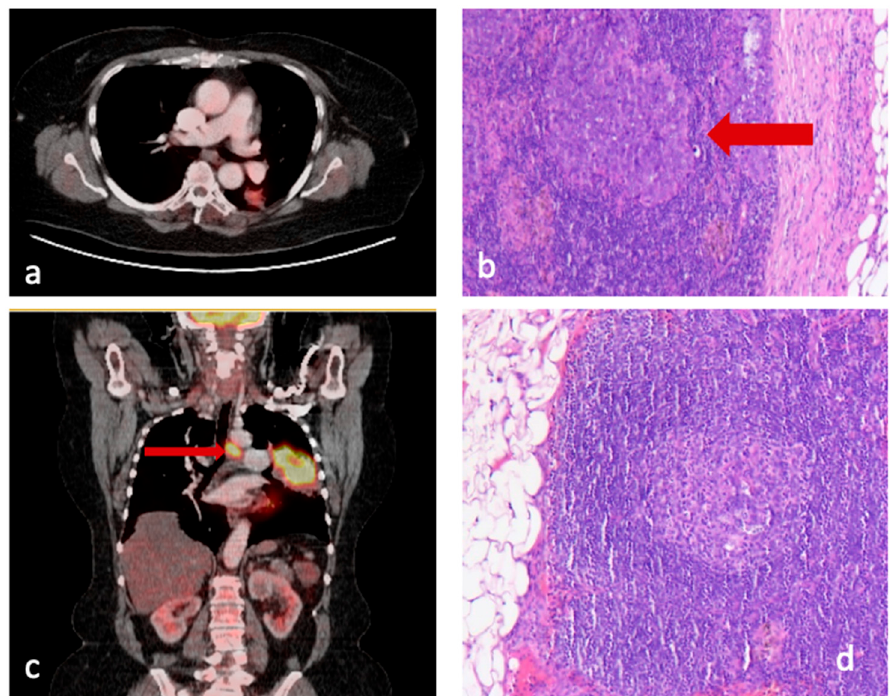
Figure 1. ( a ) PET/CT scan of patient in group 1.2, where there is no suspected LNM; ( b ) Pathological specimen of same patient with HE stain showing metastasis; ( c ) PET/CT scan of patient in group 2.2 with suspected LNM; ( d ) Pathological specimen of same patient with HE stain showing a lymph node free of disease.